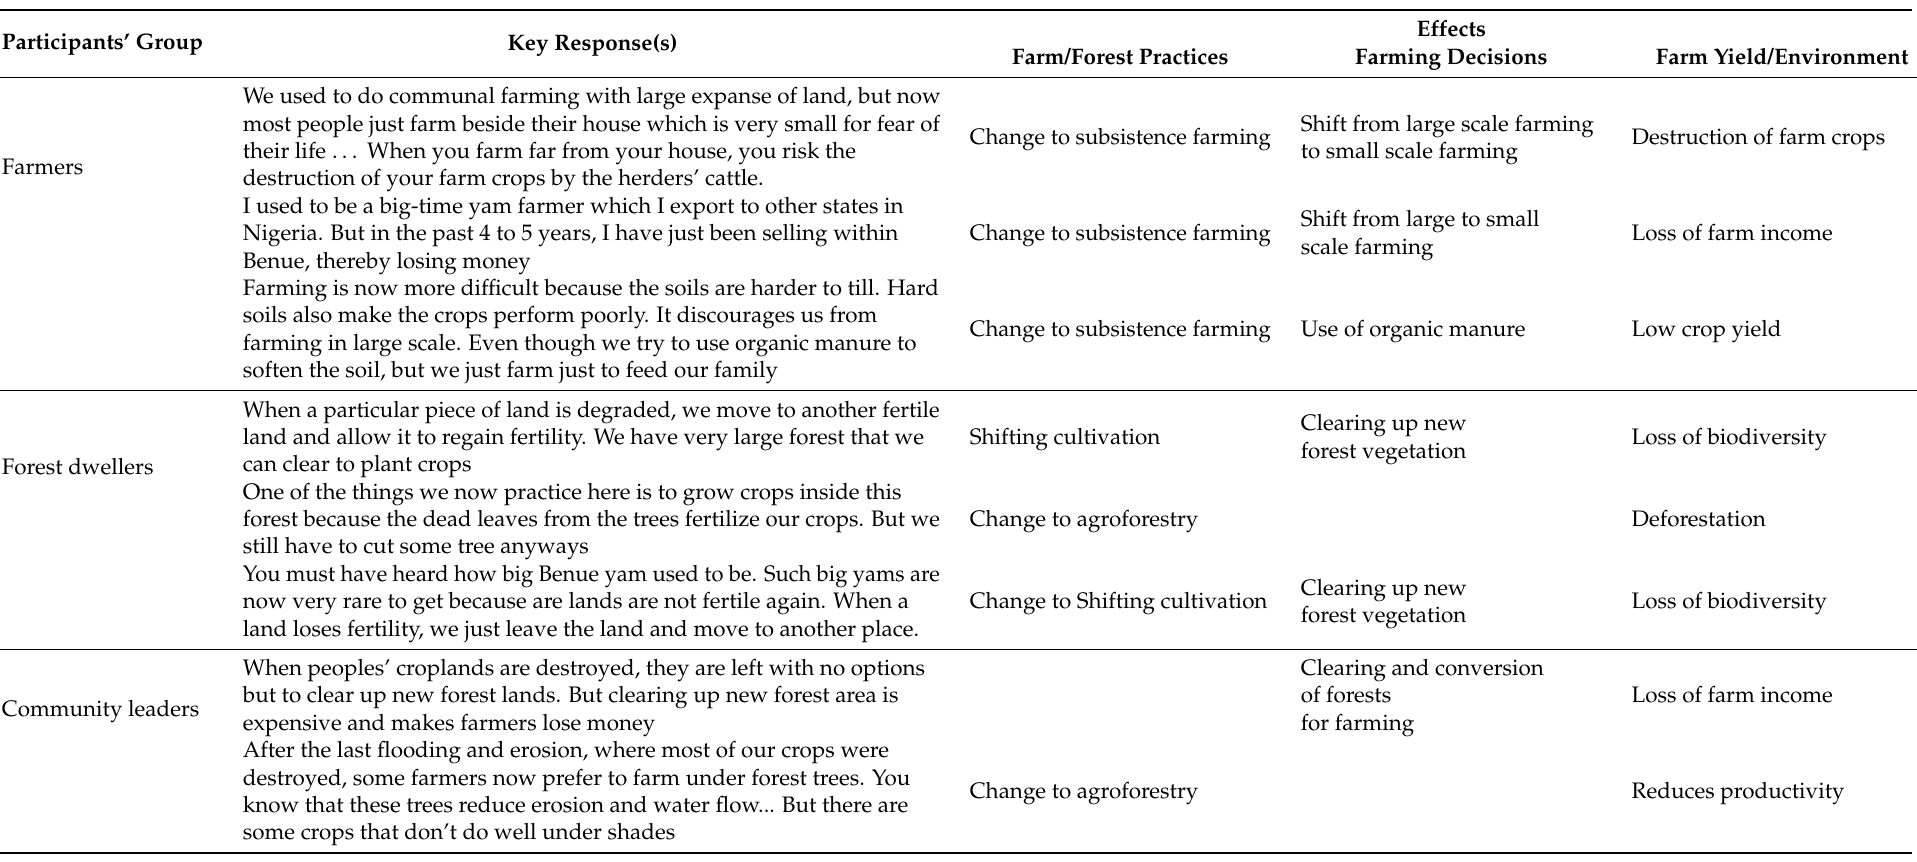
Table 5. Key responses of stakeholder on the effects of agricultural land-use change on farming or forestry practices, farming decisions, farm yield or the environment in Benue State,